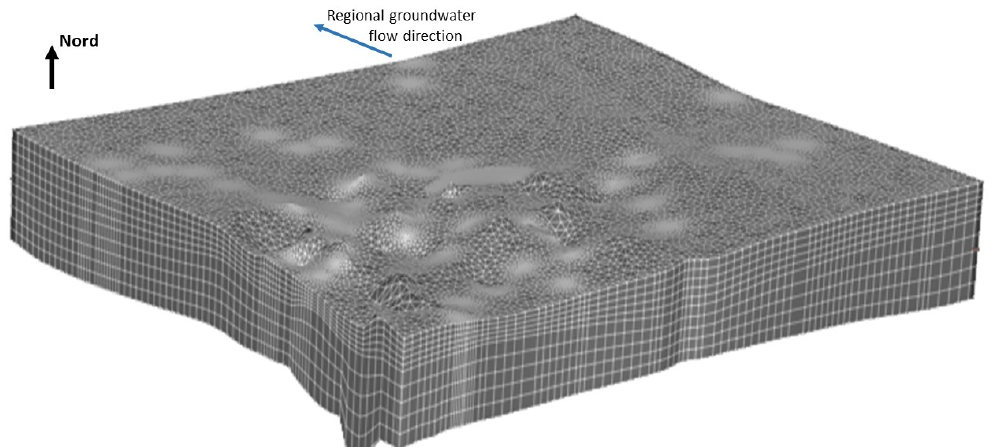
Figure 3. The 3D mesh of finite elements with local refinements around monitoring, pumping, and ATES wells.